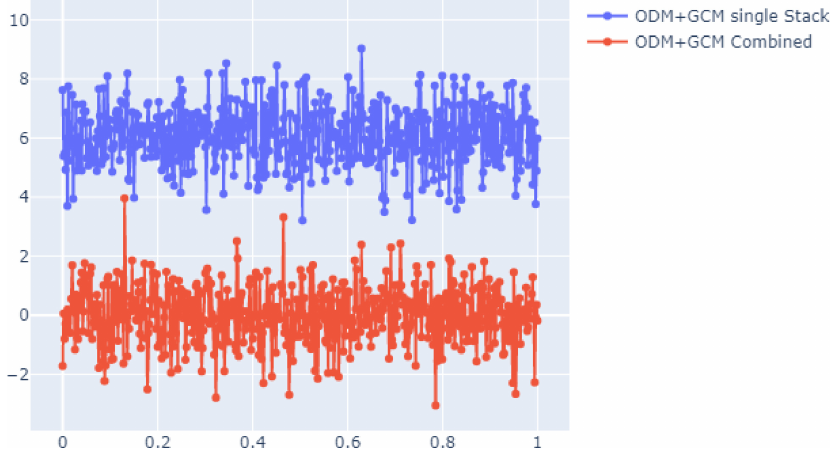
Fig. 7. Validation results from the combined model of ODM and GCM.